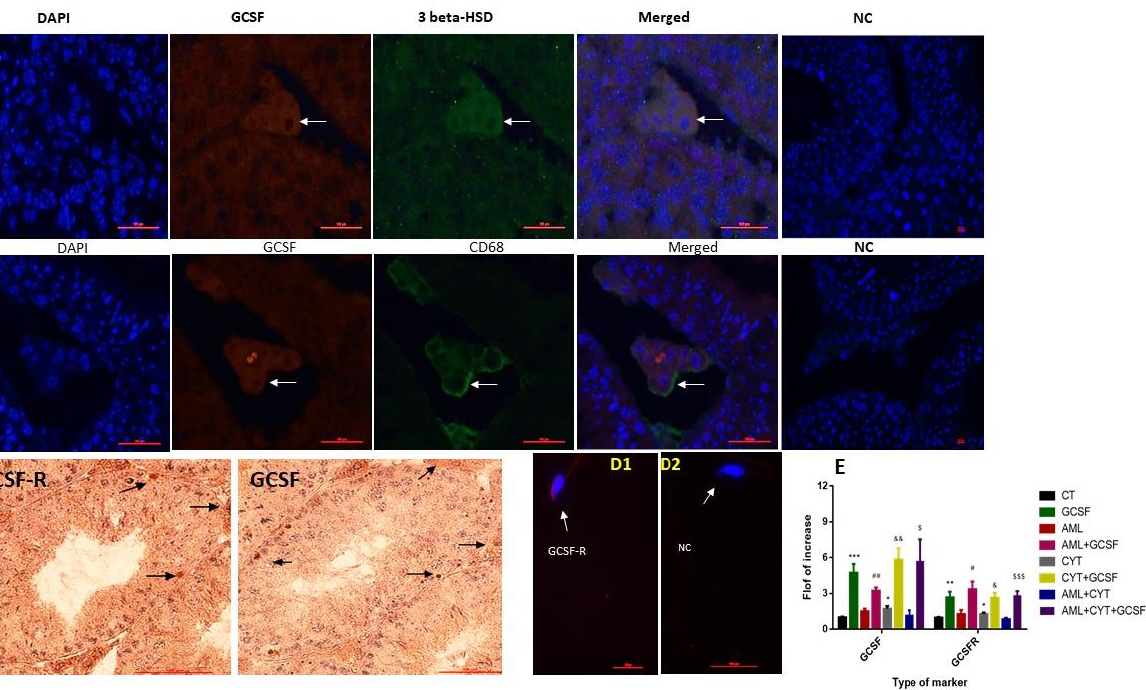
Figure 1. Localization of GCSF and GCSF-R in testicular cells, and the effect of AML and CYT on their expression in the testis. Testicular sections of untreated mice were examined by double immunofluorescence (IF) double staining for GCSF and 3 beta-HSD (as a marker of Leydig cells) ( A ), and for CD68 (a marker of macrophages) ( B ), and the images were merged (orange color). DAPI was also used to show the nucleus of the cells (DAPI; blue staining). Negative control (NC) staining of the tissues was performed as described in the Materials and Methods section and did not show staining of the examined markers. Immunohistochemical (IHC) staining were used to identify the localization of GCSF and its receptor (GCSF-R) in the seminiferous tubules and interstitial of the testis ( C ) by using specific primary antibodies. Negative control (NC) staining of the tissues was performed as described in the Materials and Methods section and did not show staining of the examined markers. In addition, the localization of GCSF-R was examined in the sperm by IF staining using specific antibodies ( D1 ) compared to the negative control (NC) ( D2 ), without the primary antibodies. DAPI was also used to show the nucleus of the cells (DAPI; blue staining). Arrows indicate the specific cells stained for each marker in the stained tissues. To evaluate the effect of post injection of GCSF on the expression levels of testicular GCSF and its receptor (GCSFR), we used qPCR analysis using specific primers for each factor. qPCR results of each marker are presented as fold of increase compared to the control group (CT) ( E ). The results are representative of 3 independent experiments with 2–3 mice in each group per experiment. *—significant compared to control (CT). #—significant compared to AML, &—significant compared to CYT, $—significant compared to AML + CYT. *,#,&,$— p < 0.05; **,##,&&— p < 0.01; ***,$$$— p < 0.001. Scale bar: 500 µ